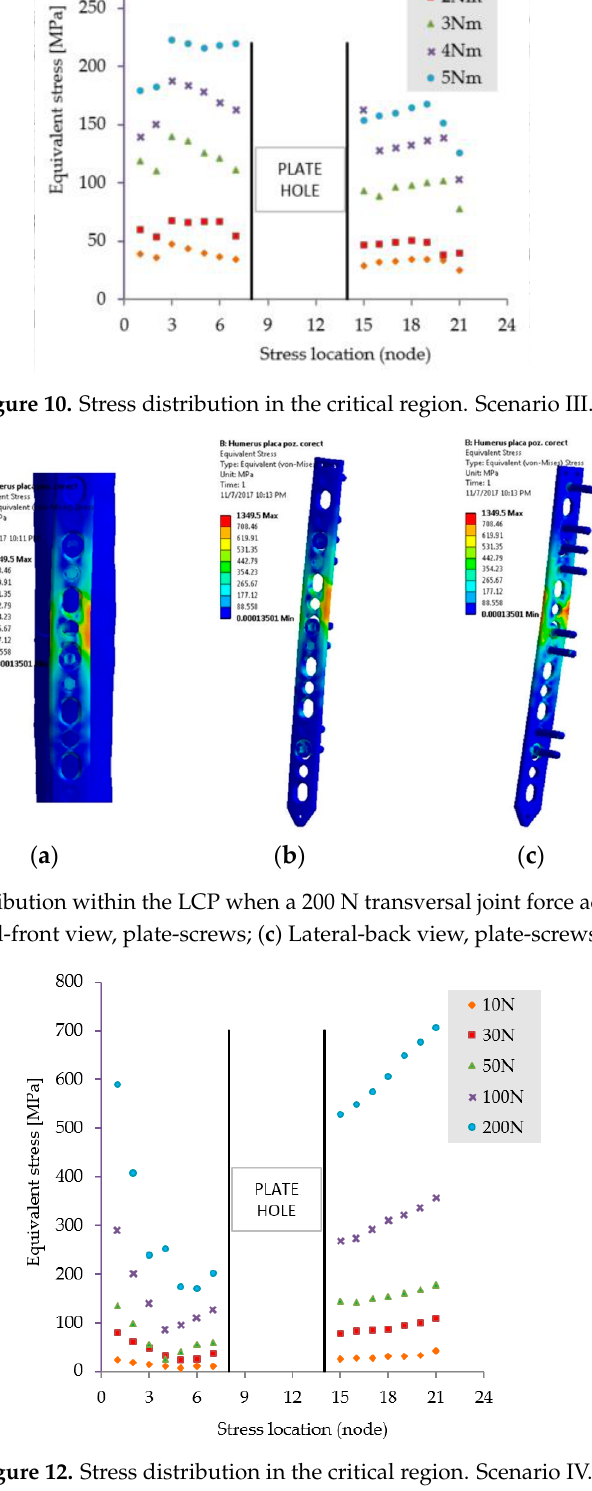
Figure 12. Stress distribution in the critical region. Scenario IV.